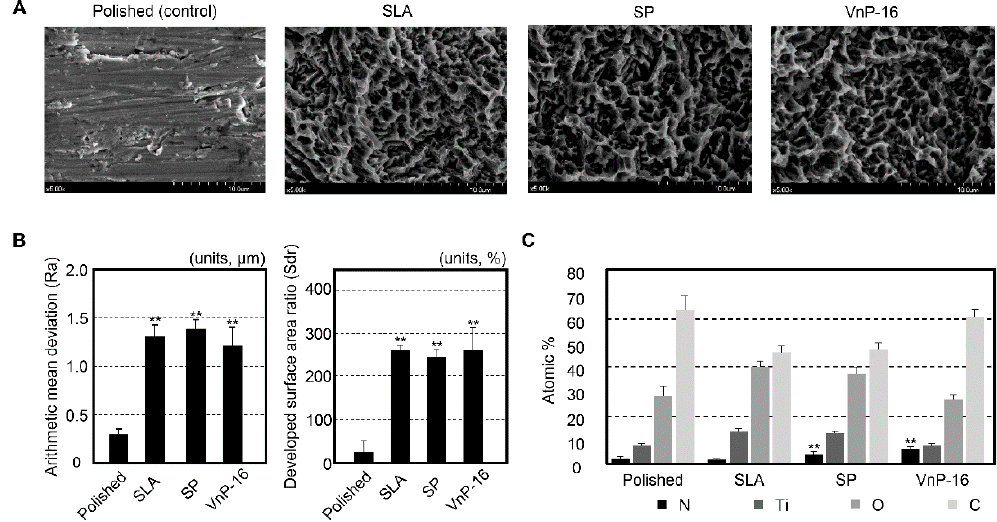
Figure 1. Surface characteristics of the titanium specimens investigated in this study. ( A ) Field emission scanning electron microscopy definitely shows di ff erent topographical features between the polished and sandblasted, large-grit, acid-etched (SLA) surfaces. ( B ) The mean values of the measured surface parameters indicated that the peptide treatment did not change the surfaces physically at the micro level. Note the significant di ff erences in the surface parameters between the polished and the other SLA surfaces. ** p < 0.01 vs. the polished surface. ( C ) Electron spectroscopy for chemical analysis detected high nitrogen content on the peptide-treated surfaces. Almost no nitrogen was found in the other groups. ** p < 0.01 vs. the polished and SLA surfaces (significant di ff erences are marked only for the nitrogen content).